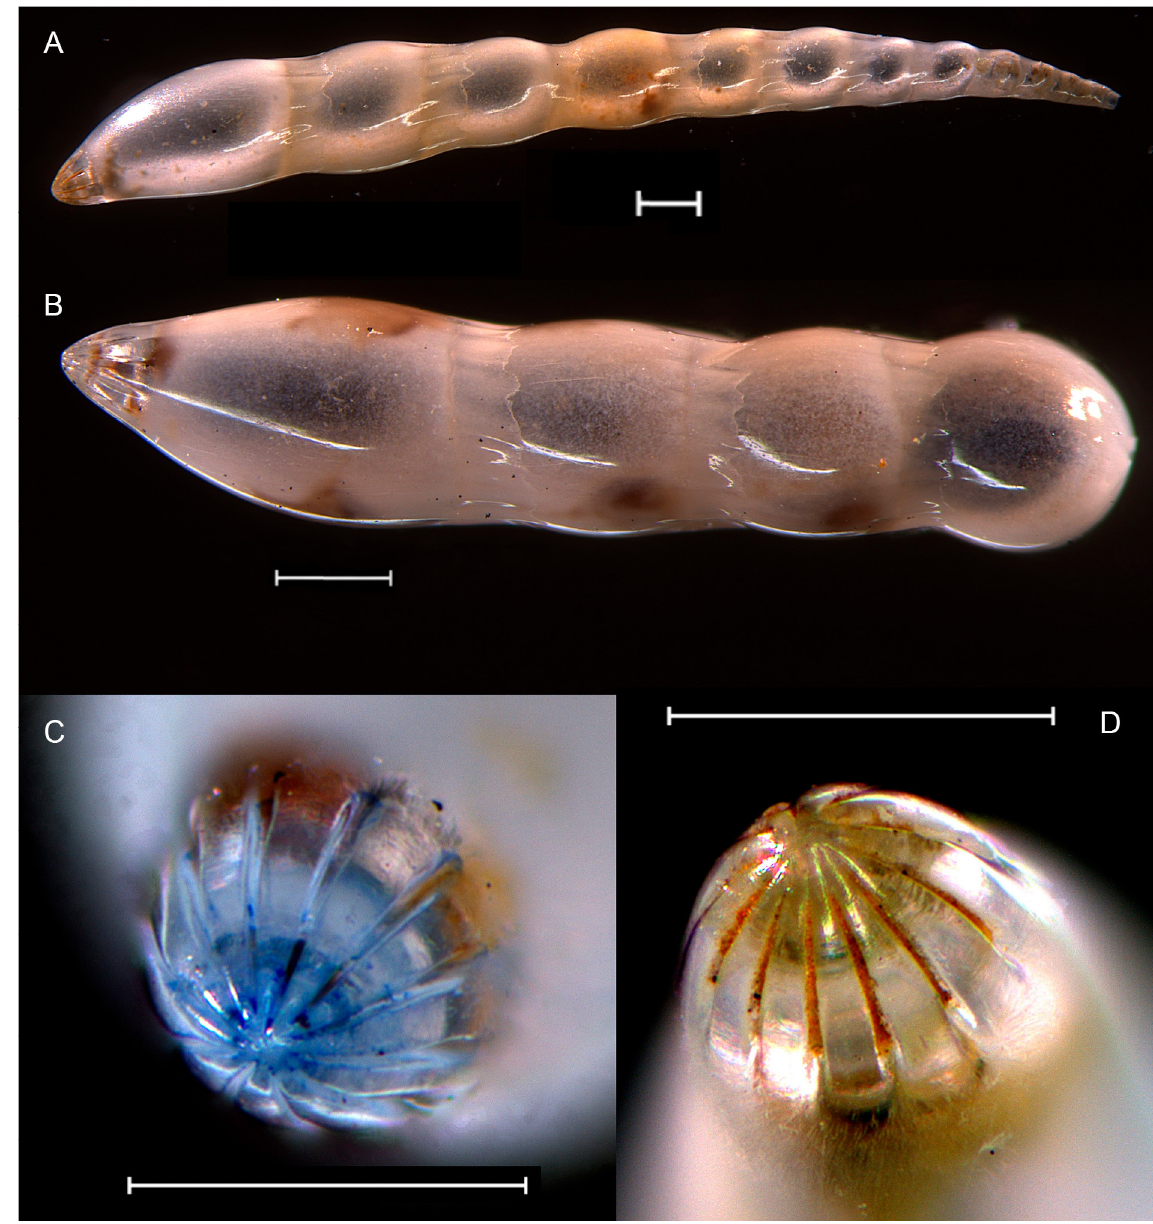
Fig. 2. Dentalina antennula d’Orbigny, 1846. A, D . Microsphere (BIOICE 2398; IINH 40362) side view (A), and aperture (D). B–C . Megalosphere (BIOICE 2222, IINH 40365), side view (B) and aperture (C), stained with indigo blue. Light source incident light and dark field. Scale bars = 0.25